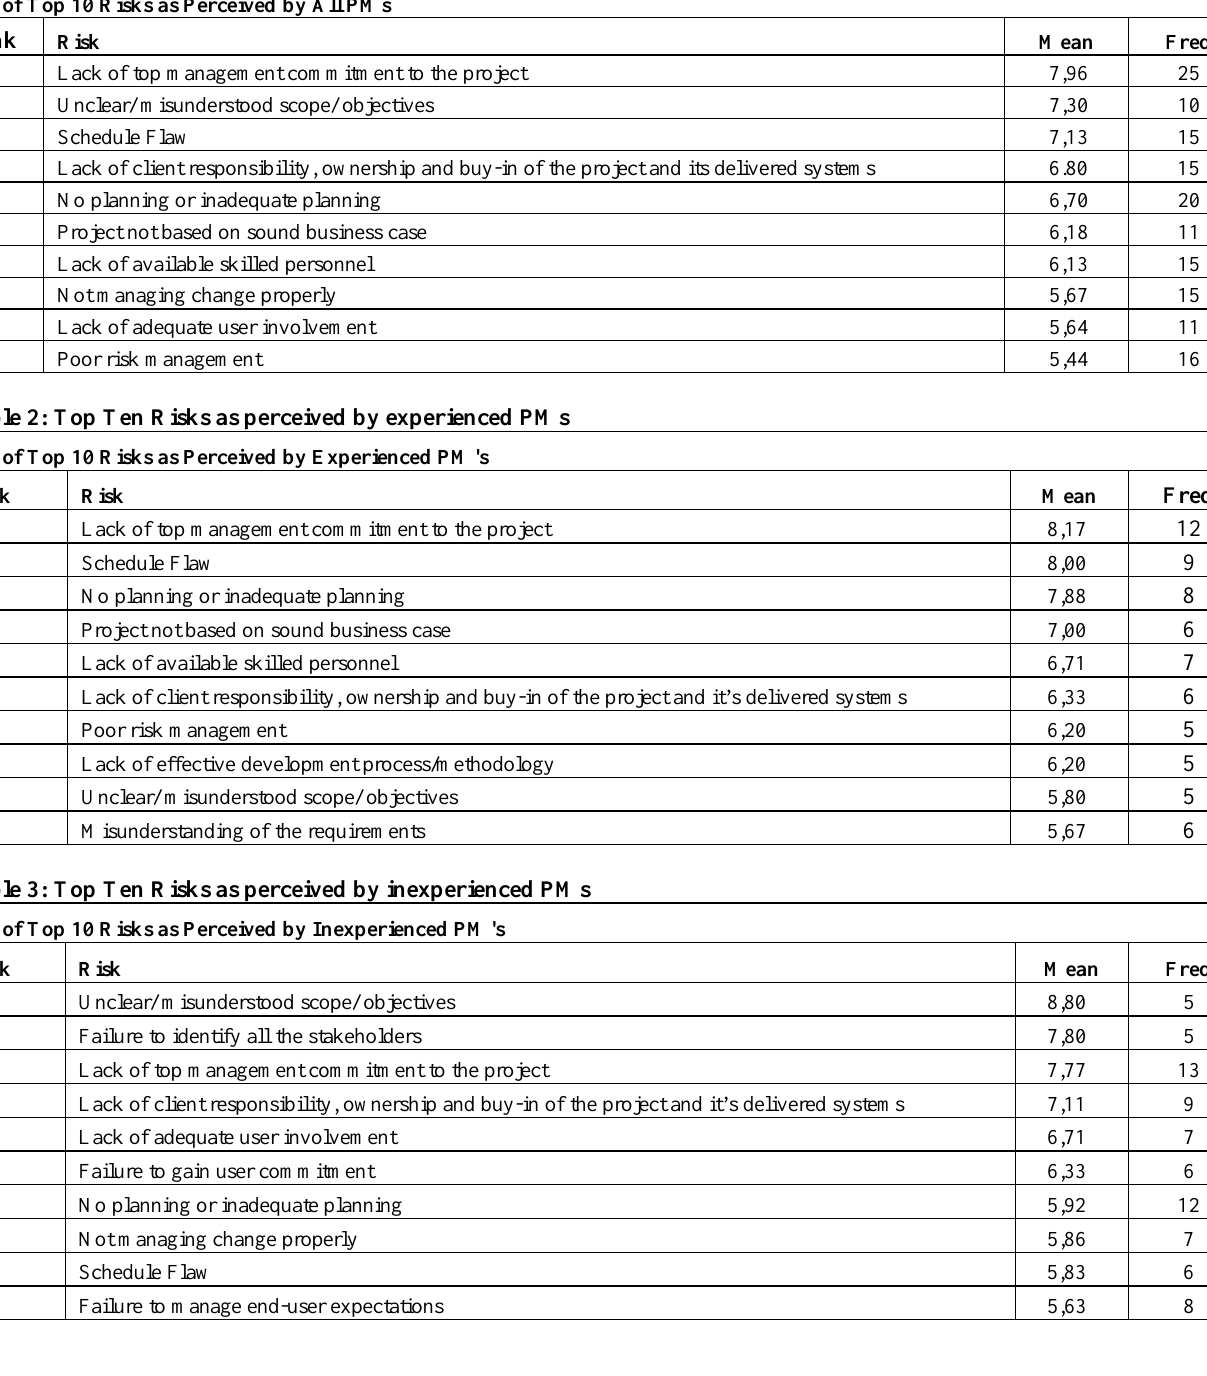
Table 1: Top en Risks as perceived by all PMs List of Top 10 Risks as Perceived by All PMs